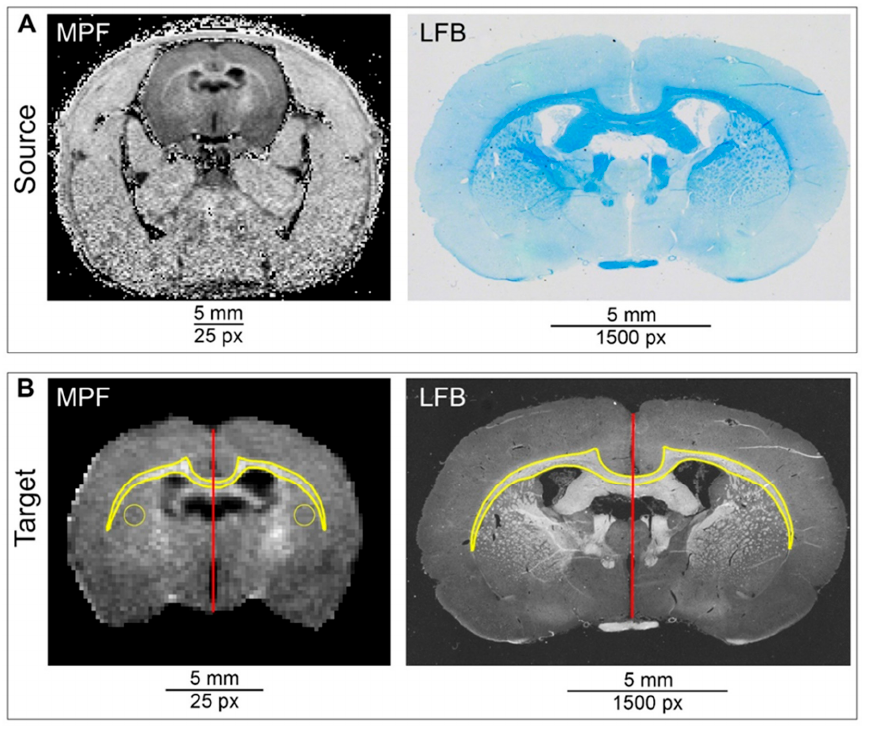
Figure 2. Pre-processing of MR and histological images. ( A )Example of source (MR) and target (histological) images. Source image is represented by one slice of 3D MPF map; target image is presented by a micrograph of anatomically matched brain section stained with LFB. ( B )Source and target images after pre-processing with ROI selection. ROIs for measurements and method validation (delineated corpus callosum and two symmetrical round ROIs in the left and right caudoputamen) are marked with a yellow line. Linear red line ROIs are added for a vertical size assessment of the source and target images which are necessary for further transformation and scaling.